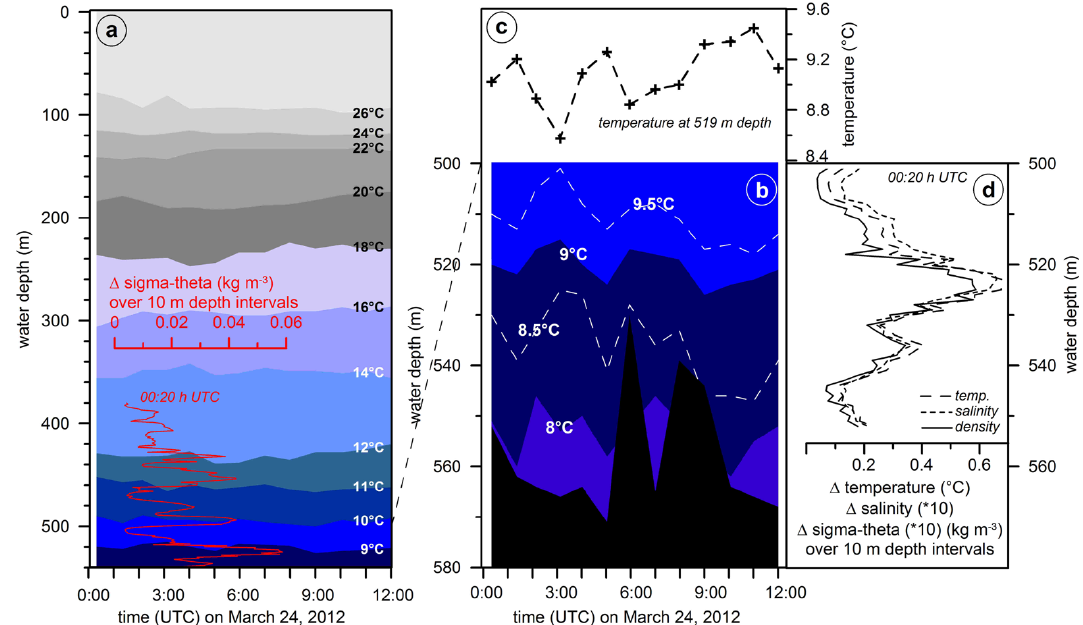
Fig. 6. Hydrological variability derived from the Yoyo CTD station GeoB 16316 (see also Table 1 and Fig. 1). (a) Variability of the tempera- ture distribution in the entire water column over a time interval of 12h (comprising 13 individual CTD casts). The red inset shows the density gradient over 10m depth intervals for the water column below 380m taken from CTD cast GeoB 16316-1 (00:20UTC). (b) Depth variation of the 8 ◦ C to 9.5 ◦ C isotherms in the lower part of the water column > 500m water depth over the same time period shows partly vertical movements of > 20m. Variations in water depth (black denotes the sea floor) are caused by slight movements of the vessel ( ∼ 600m N–S, ∼ 50m E–W) at the Yoyo CTD station (including the crossing of a CWC mound). (c) Water temperature at 519 m depth measured over the same time period indicates a variability of up to 1 ◦ C. (d) Gradients in temperature, salinity, and density over 10m depth intervals. Data were obtained during the individual CTD cast GeoB 16316-1 (00:20UTC) and reveal particularly strong gradients around 520m water depth (see also a